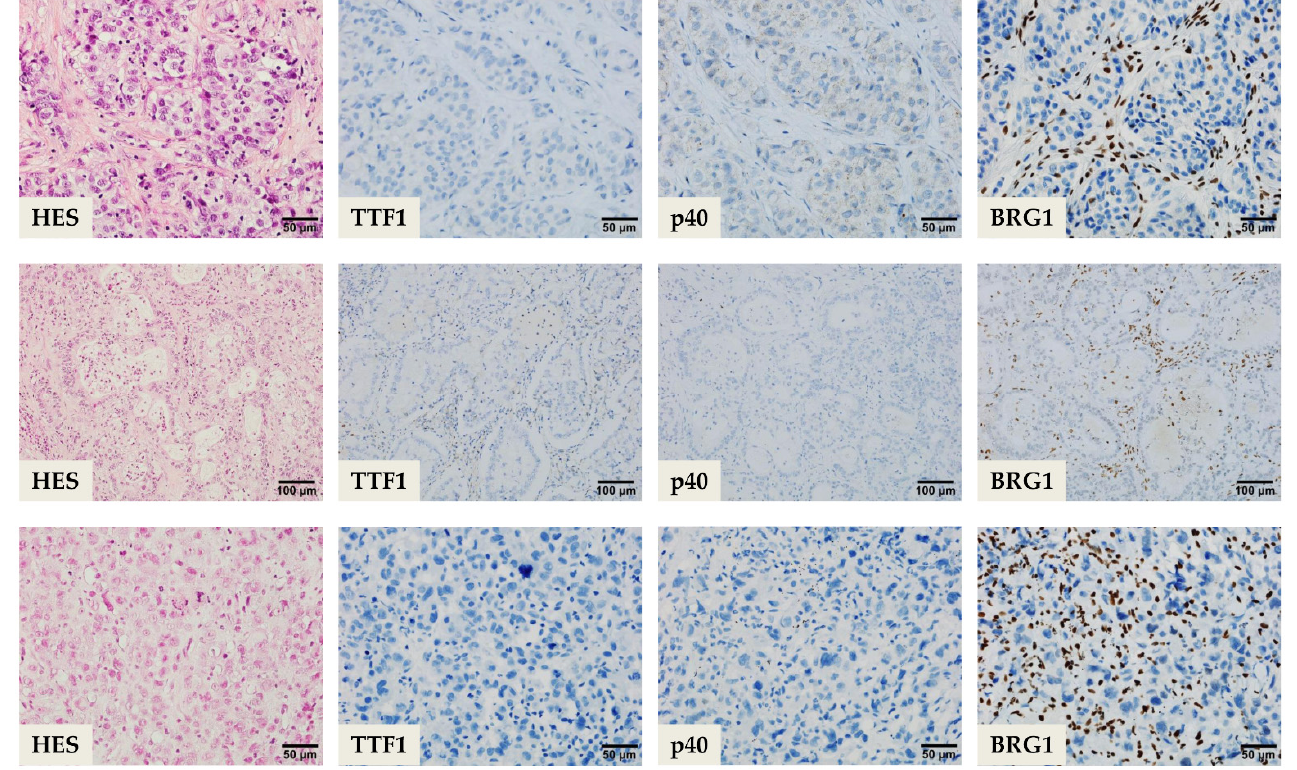
Figure 2. Morphologic and immunohistochemical features of thoracic SMARCA4-deficient tumors. The three main patterns are shown. Upper row, poorly differentiated solid pattern; middle row, the mucinous glandular pattern; lower row, the rhabdoid/undifferentiated sarcomatoid pattern, demonstrating a lack of expression of TTF1 and p40. Immunohistochemical loss of SMARCA4 (BRG1) expression in tumor cells, with internal positive control staining in inflammatory and stromal cells. Scale bars are presented.